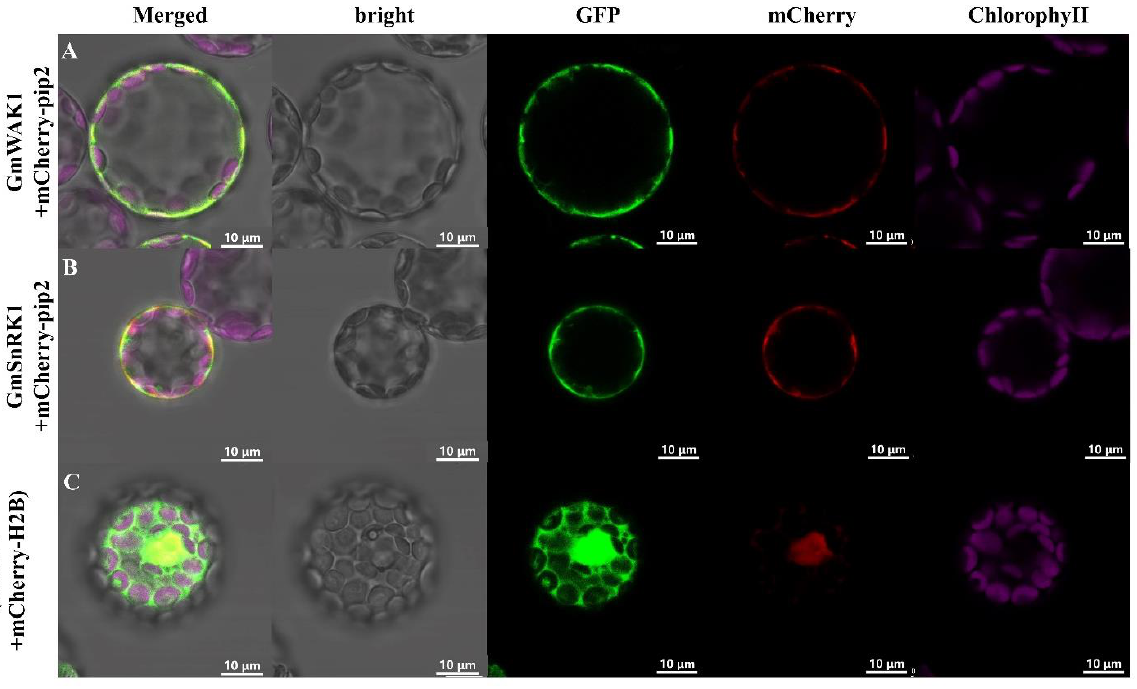
Figure 2. Subcellular localization of GmWAK1. GmWAK1-GFP fusion protein was transiently ex- pressed in Arabidopsis protoplasts; plasmid containing p2300-35S-H2B-mCherry (recombinant histone H2B) was cotransformed as a nuclear marker; p2300-35S-PIP2-mCherry (plasma membrane intrinsic proteins) was cotransformed as a cell membrane marker. Images of bright-field, green fluorescent protein (GFP) fluorescence (green) only, red fluorescent protein (mCherry) fluorescence (red) only, chlorophyll autofluorescence (purple) only, and their combination. Scale bars: 10 µm.